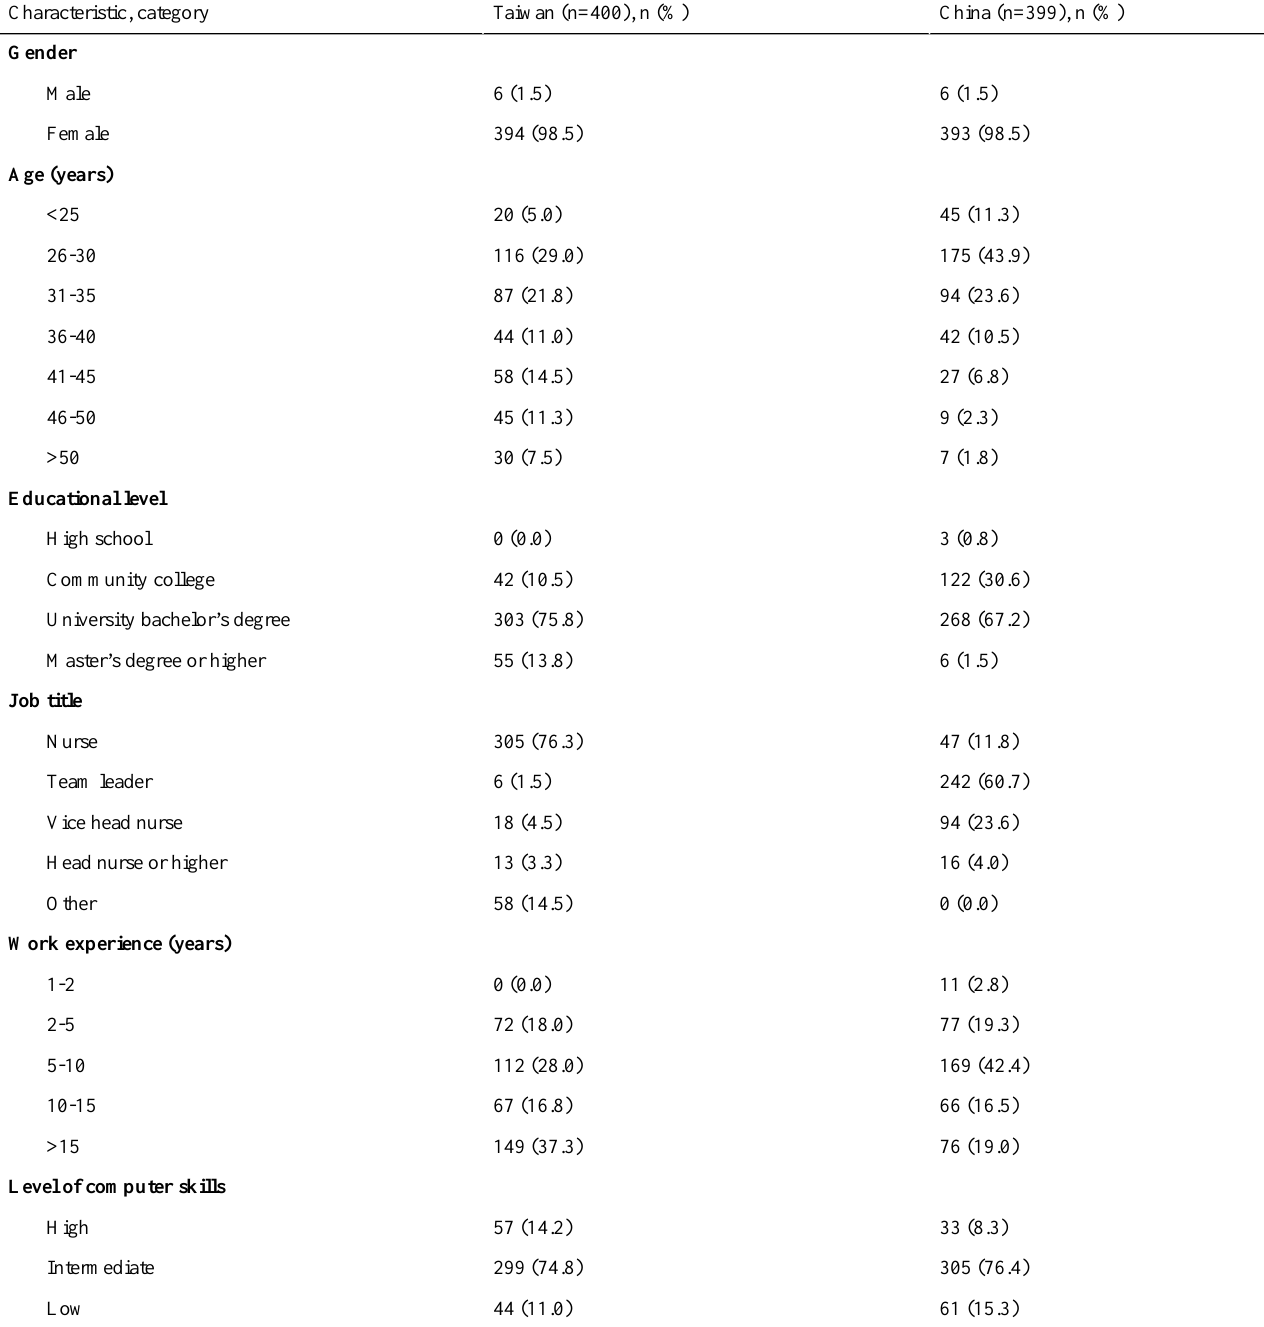
Table 2. Demographic characteristics of participants from Taiwan and